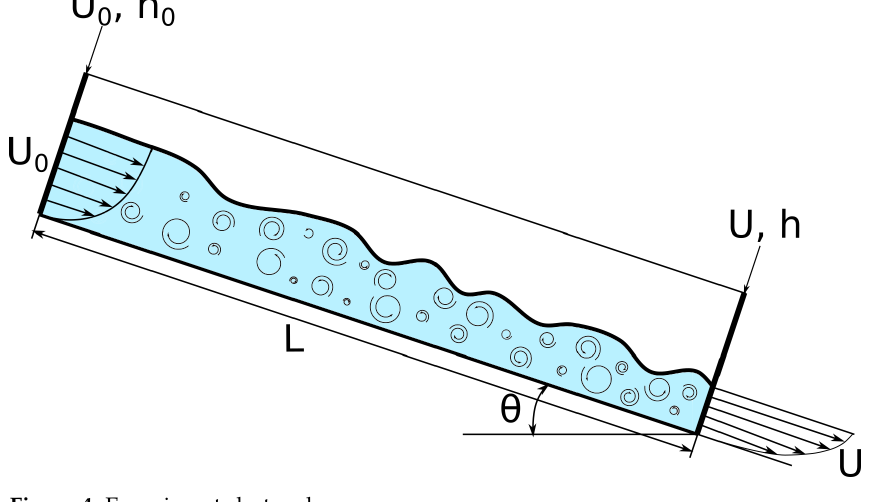
Figure 4. Experiment chute scheme.